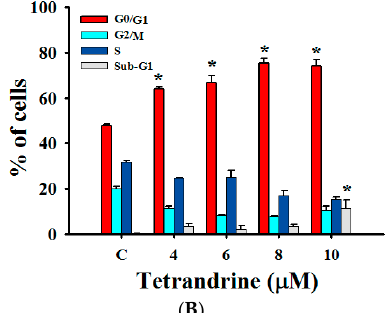
Figure 3. TET induces G 0 /G 1 phase arrest and sub-G 1 phase in NPC-TW 076 cells . Cells (1 × 10 5 cells/well) in 12-well plates and were incubated with TET (0–10 μ M) for 48 h. Cells were harvested and fixed in 70% ethanol and then incubated with a solution containing 50 mg/mL PI and 50 μ g/mL RNase A for were evaluated for the percentage of cell cycle distribution ( B ) as described in Materials and